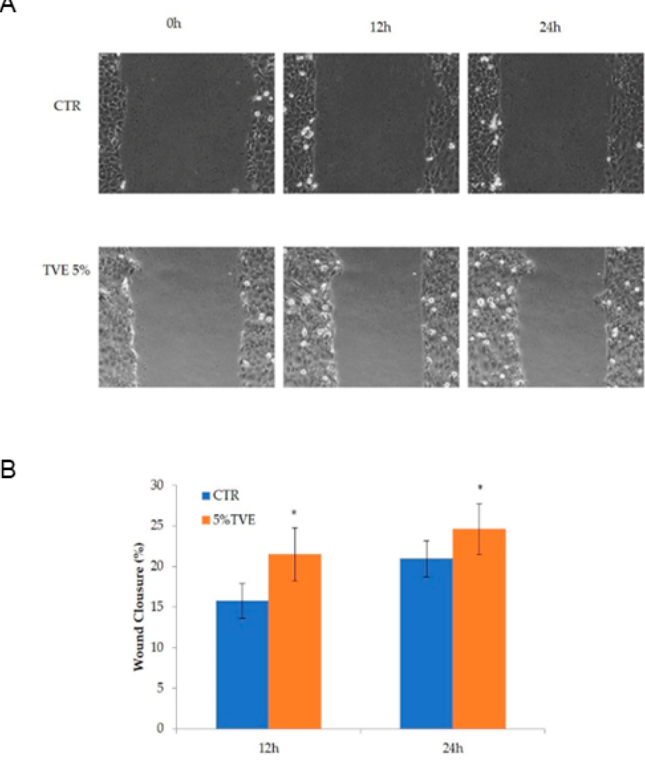
Figure 2. ( A ) Representative panel of scratched cell monolayers during incubation in the control and in the presence of TVE at 5% v/v . ( B ) Quantitative analysis of wound closure at 12 and 24 h. Six fields of view were measured for each sample. * p < 0.05.